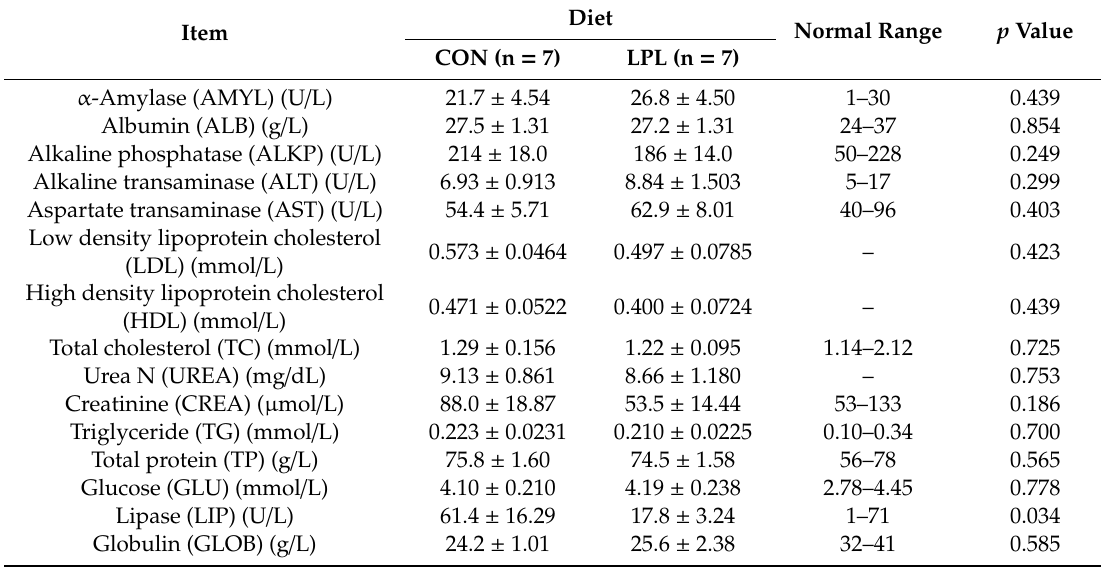
Table 5. Serum biochemical parameters of fattening lambs fed experimental diets supplemented without (CON) or with (LPL)